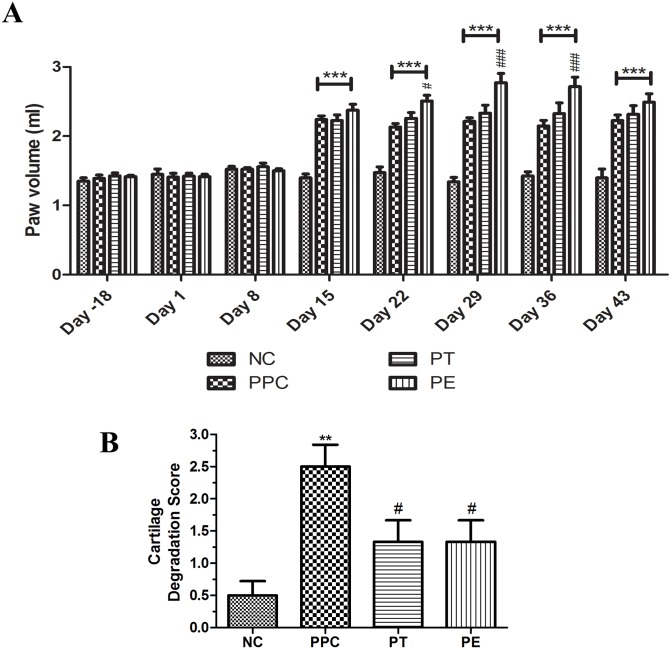
Paw volume and cartilage degradation scoring of prophylactically treated groups.(A) Paw volume changes in prophylactically treated groups from day -18 to 43 (values analyzed using RM- ANOVA with Graph Pad prism); "***" indicates significant difference compared to NC (P<0.001); "#" indicates significant difference compared to PPC (### represents P<0.001 and # represents P<0.05); values represented in Mean ± SEM, n = 12. (B) Cartilage degradation scores from histomorphological sections of prophylactically treated groups; "**" indicates significant difference from NC (P<0.01); statistically significant differences between PPC and PT or PE groups indicated as "#" (P<0.05); values represented in Mean ± SEM, n = 6.